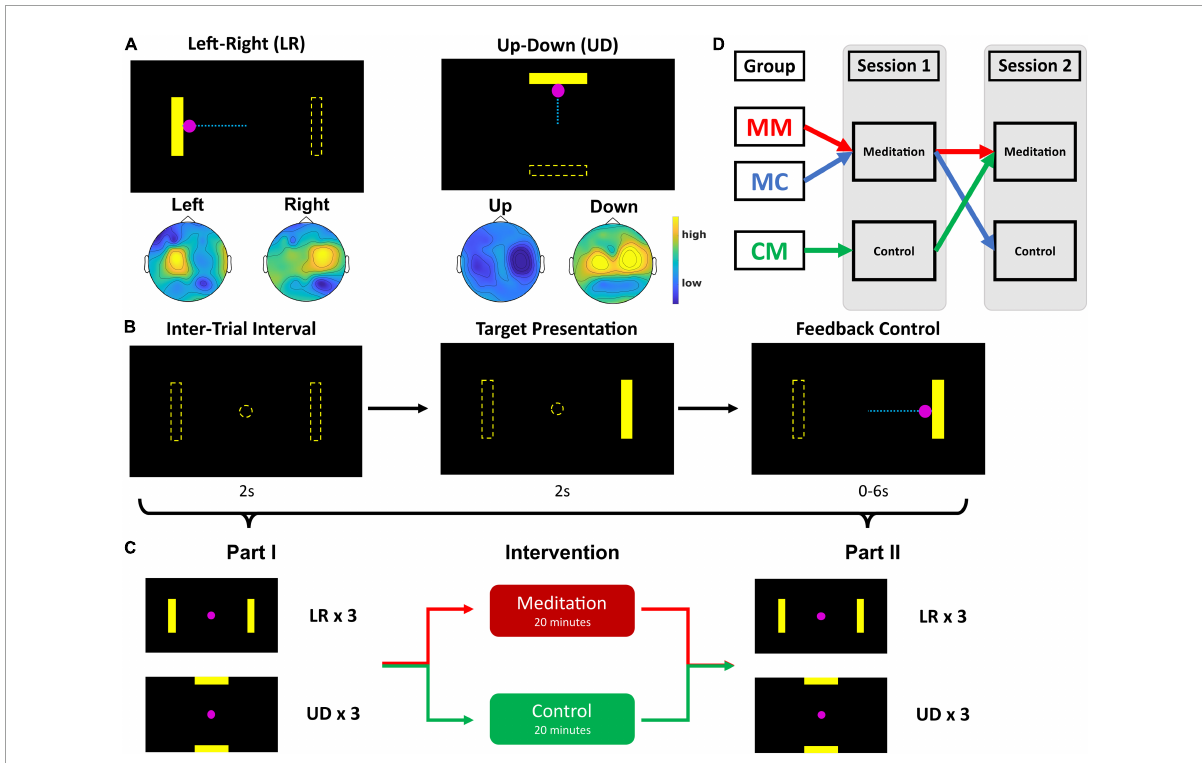
FIGURE1 Schematic diagram of study design. (A) BCI tasks. Left-right (LR) and up-down (UD), the dashed lines are for illustrative purposes only and were not visible in the actual experiment. Scalp topographies show regions of mu power increase (yellow) and decrease (blue) during each trial type (i.e., left vs right and up vs down). The colors represent the distribution of mu rhythm power calculated for each electrode during the different trial types. (B) Each trial: 2 s of intertrial interval, 2 s of target presentation, and up to 6 s of cursor control with visual feedback. (C) Session design: Each session consists of part 1, intervention, and part 2. Part 1 contains 3 runs of LR and 3 runs of UD, where one run consists of 25 trials of BCI control. Intervention is either a 20-min meditation or control task, and part 2 contains 3 runs of LR and 3 runs of UD tasks each (practice runs for the LR and UD tasks in session 1 are not included in the figure). (D) Group assignment: Group MM ( N = 10) performed brief meditation with audial guidance in both sessions; group MC ( N = 12) performed meditation with audial guidance in session 1 and listened to control recording in session 2; group CM ( N = 15) listened to control recording in session 1 and performed brief meditation with audial guidance in session